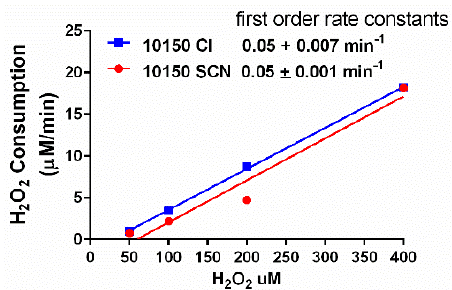
Figure 3. Comparison of the hydrogen peroxide consumption of the chloride and thiocyanate salts of AEOL10150. Samples were incubated with 25 µ M of 10150 chloride (-Cl) or thiocyanate (-SCN) formulations and increasing amounts of H 2 O 2 . H 2 O 2 consumption was determined over 1 min using a H 2 O 2 electrode. First-order rate constants were determined from a linear regression analysis. Hydrogen peroxide can be scavenged by either a catalase-like reaction or a peroxidase reaction. The catalase dismutation of H 2 O 2 results in the formation of oxygen and water, whereas the peroxidase reaction does not generate oxygen and instead generates water and an oxidized product. − SCN is a known endogenous substrate for haloperoxidases [27]. To